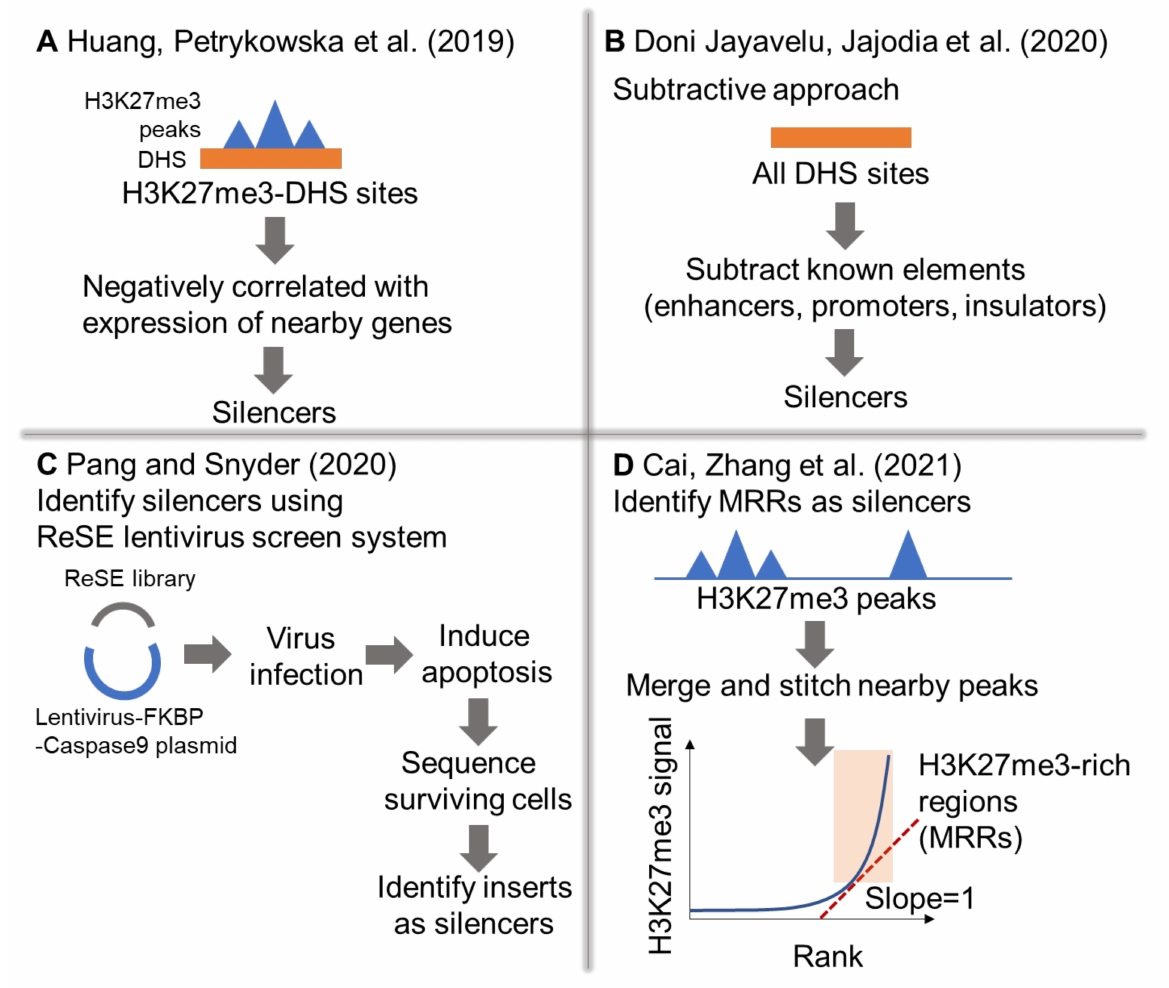
Figure 1. Different identification methods of human silencers. ( A ) H3K27me3-DHS sites that were negatively correlated with expression of nearby genes in different cell lines were termed silencers. DHS— DNase I hypersensitive sites. ( B ) Identifying silencers using the subtractive approach. ( C ) Identifying human silencers by high-throughput functional screen via measuring the repressive ability of silencer elements (ReSE). ( D ) Identifying H3K27me3-rich regions (MRRs) as